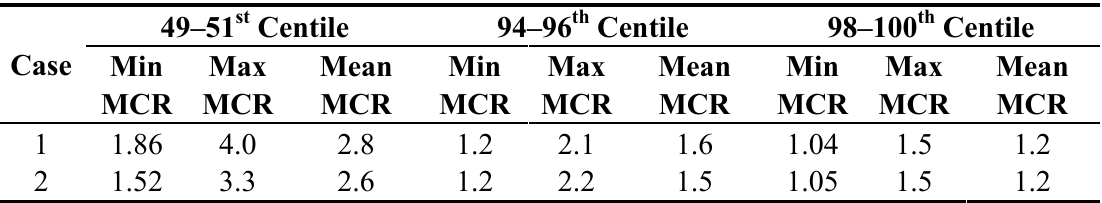
Table 8. Comparison of the MCR values of three portions of mixtures in Cases 1 and 2.